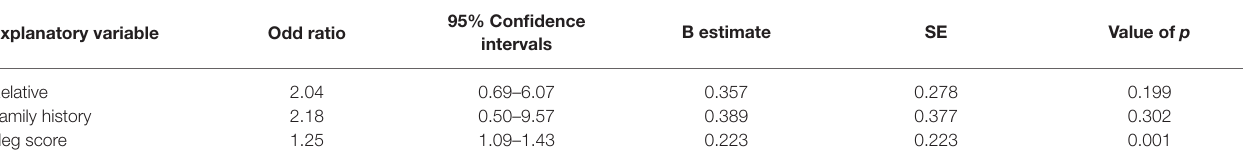
TABLE 8 | Associations between the clients’ characteristics and MCQJ-30 score with state anxiety using multiple logistic regression analysis. Explanatory